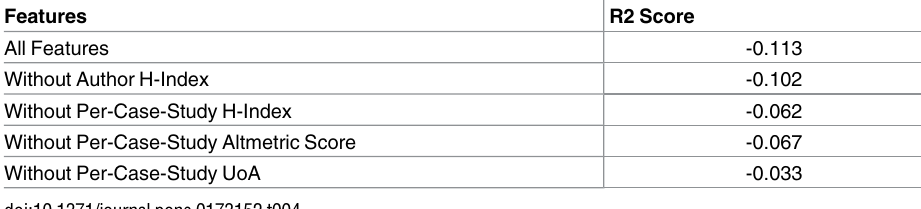
Table 4. Regression Model Prediction